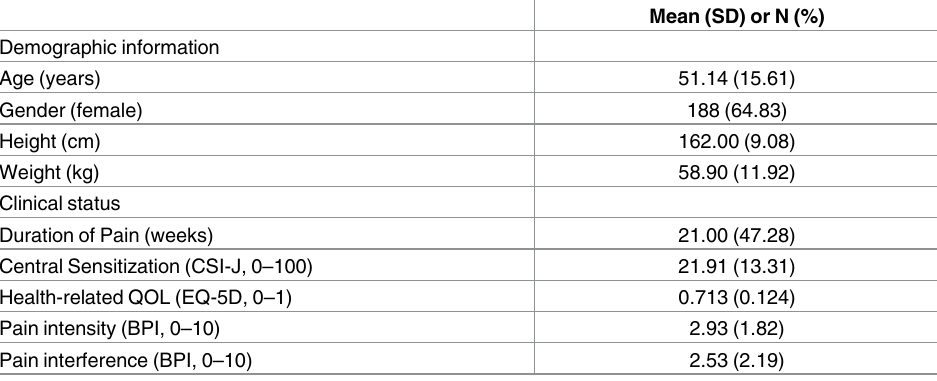
Table 1. Characteristics of participants.